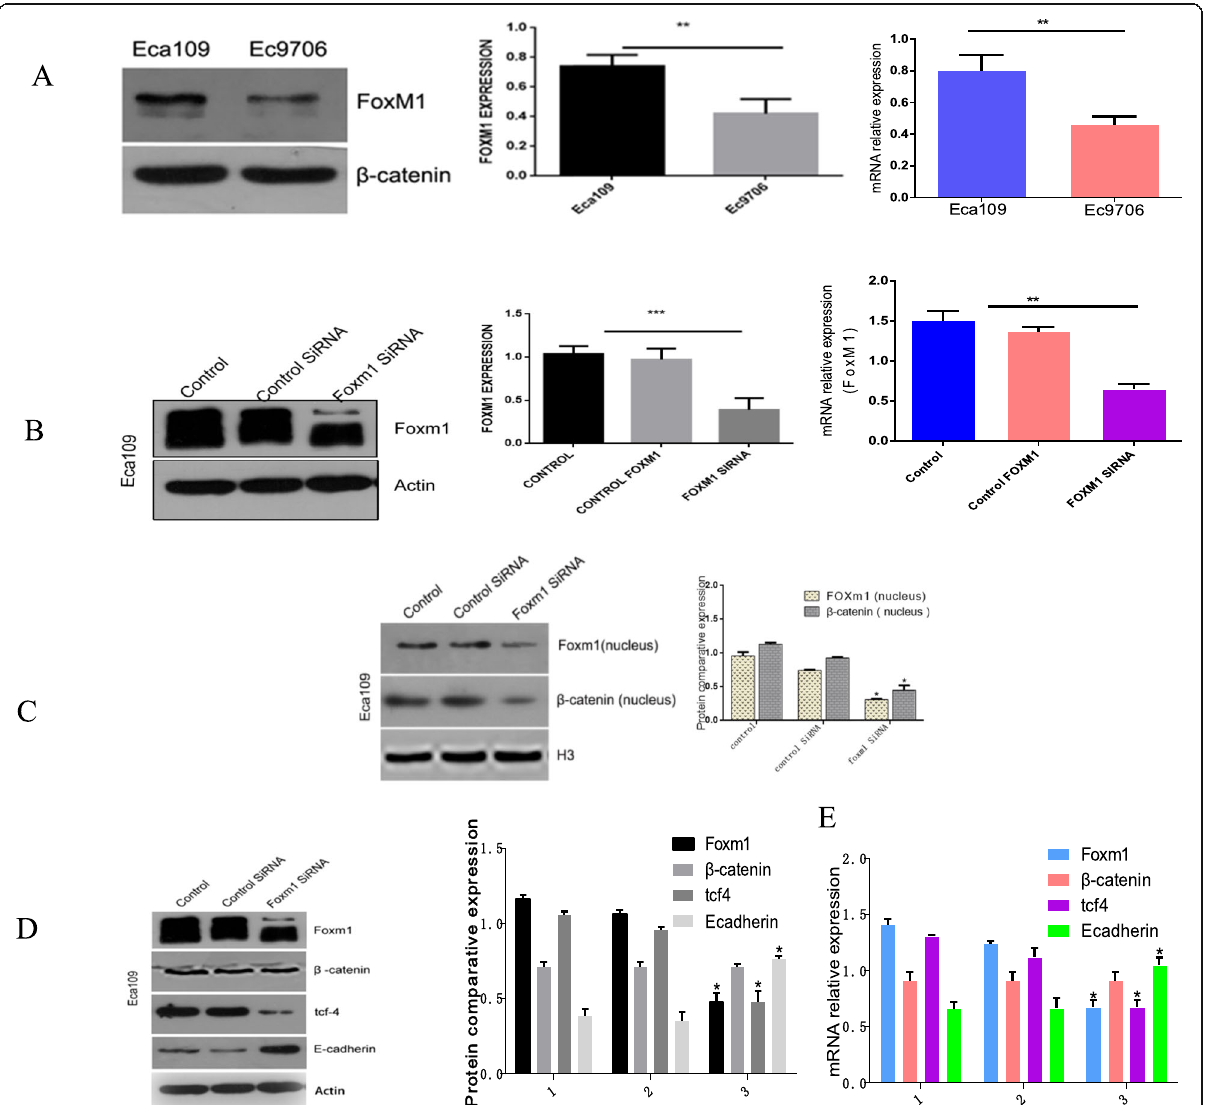
Fig. 4 a Top panel: Western blotting and RTq-PCR analysis of Foxm1 expression in Eca109 and Ec9706 cells, respectively. Bottom panel: Quantitative analysis *P<0.05; b Top panel: Foxm1 expression of three groups of EC cells following FoxM1 silencing. Bottom panel: Quantitative data for the top panel. * P <0.05; c Top panel: Western blotting to detect Foxm1 and β -catenin expression in the nuclei of the three groups EC cells after FoxM1 silencing. Bottom panel: Quantitative data for the top panel. *P<0.05; d Top panel: Western blotting to detect the expression of Foxm1, β -catenin, tcf4, and E-cad in the three groups of EC cells after FoxM1 silencing. Bottom panel: Quantitative data of the top panel. *P<0.05; e Top panel: RT-PCR to measure the mRNA levels of Foxm1, β -catenin, tcf4 and E-cad in the three groups of EC cells after FoxM1 silencing. Bottom panel: quantitative data for the top panel. * P